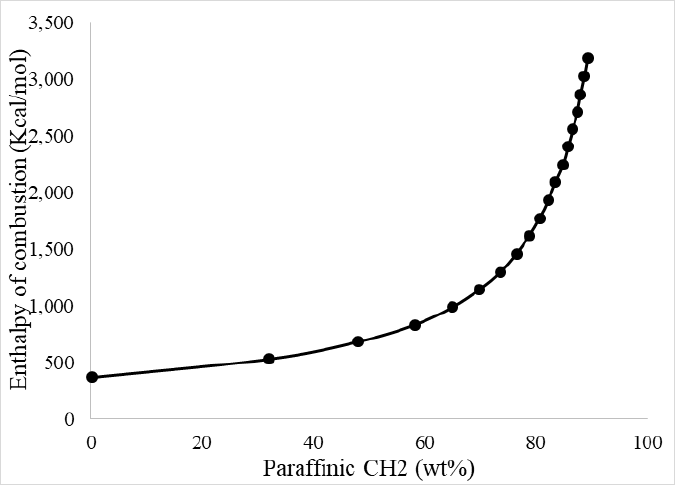
Figure 3. The effect of weight percentage of CH2 on enthalpy of combustion for n-paraffins .